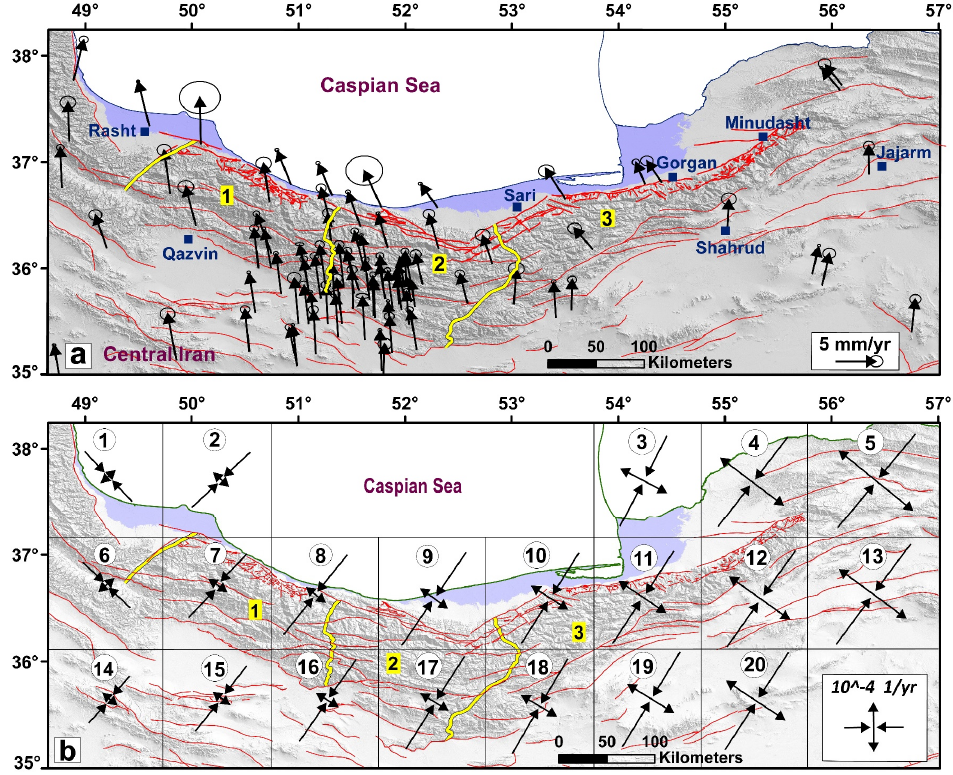
Figure 5. ( a ) The GPS velocity field with their error ellipses in the area which are relative to the Eurasian reference frame. ( b ) The principal axes of the geodetic strain rate obtained from the GPS velocities. Labels within grids show grid number. Numbers 1, 2, and 3 are location of the West Alborz, Central Alborz, and East Alborz, respectively which are separated by yellow lines. Table 5. The GPS velocities used in this paper which are relative to Eurasian reference frame [18,53] .